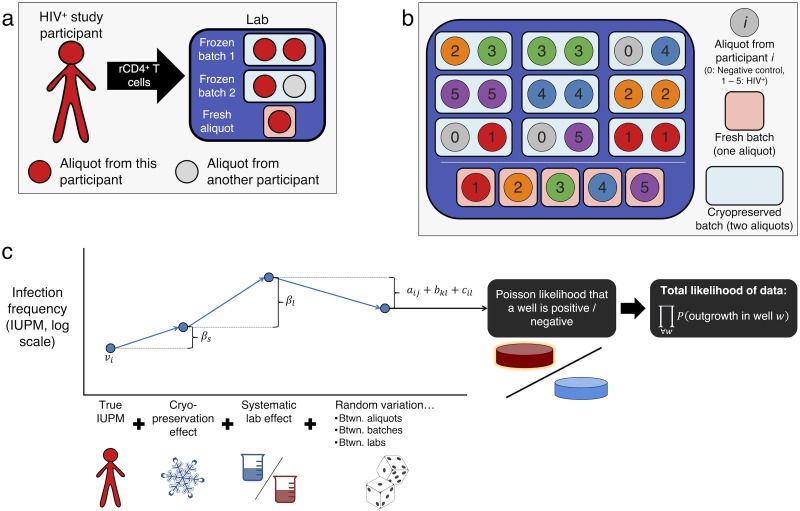
Experimental and analytical design of the study.Panel a: Three frozen aliquots were provided by each HIV+ participant to each lab; an additional fresh aliquot was provided to each lab except SR. Panel b: Experimental design at one of the four labs (U. Pitt.). Fresh panel (five batches): One aliquot from each HIV+ participant was studied fresh and was not batched with any other aliquots. Frozen panel (nine batches): Three aliquots from each participant were cryopreserved and batched together with one other aliquot. Five batches contain two aliquots from the same HIV+ participant. Two HIV+ participants are chosen to supply one aliquot to the same batch (here, participants 2 and 3). The remaining three batches contain an aliquot from one of the remaining HIV+ participants and an aliquot from the negative control. In each lab, different HIV+ participants are chosen for the mixed batch (see S1 Table for complete experimental design). Panel c: Sketch of statistical model used to estimate IUPM for each participant (vi); cryopreservation effect (βs); systematic effect for each lab (βl, set to zero for U. Pitt., which was arbitrarily chosen as reference); and random variation at the level of aliquot, batch, and lab (aij, bkl, cil, respectively). These fixed and random effects combine to determine the likelihood that a given well is positive, and the likelihood of the data equals the product of likelihoods of all wells (see Eq (3)).